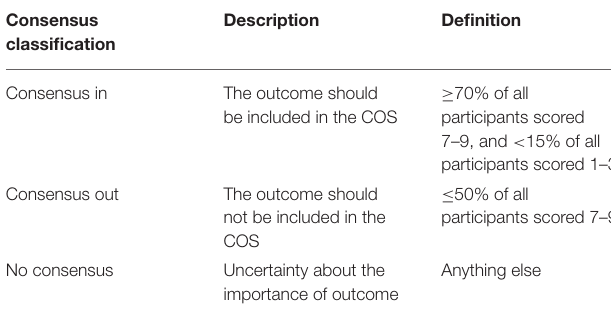
TABLE 5 | The inclusion and exclusion criteria for patients in the Delphi survey. Inclusion